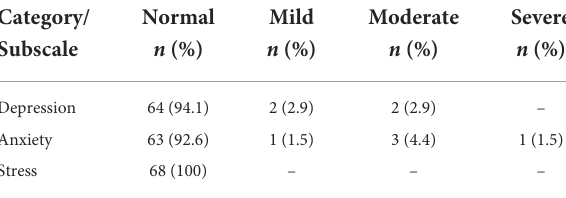
TABLE 3 The frequency and percentage of participants reported experiencing normal, mild, moderate, and severe levels of depressive, anxiety, and stress symptoms based on DASS 21 ( N =